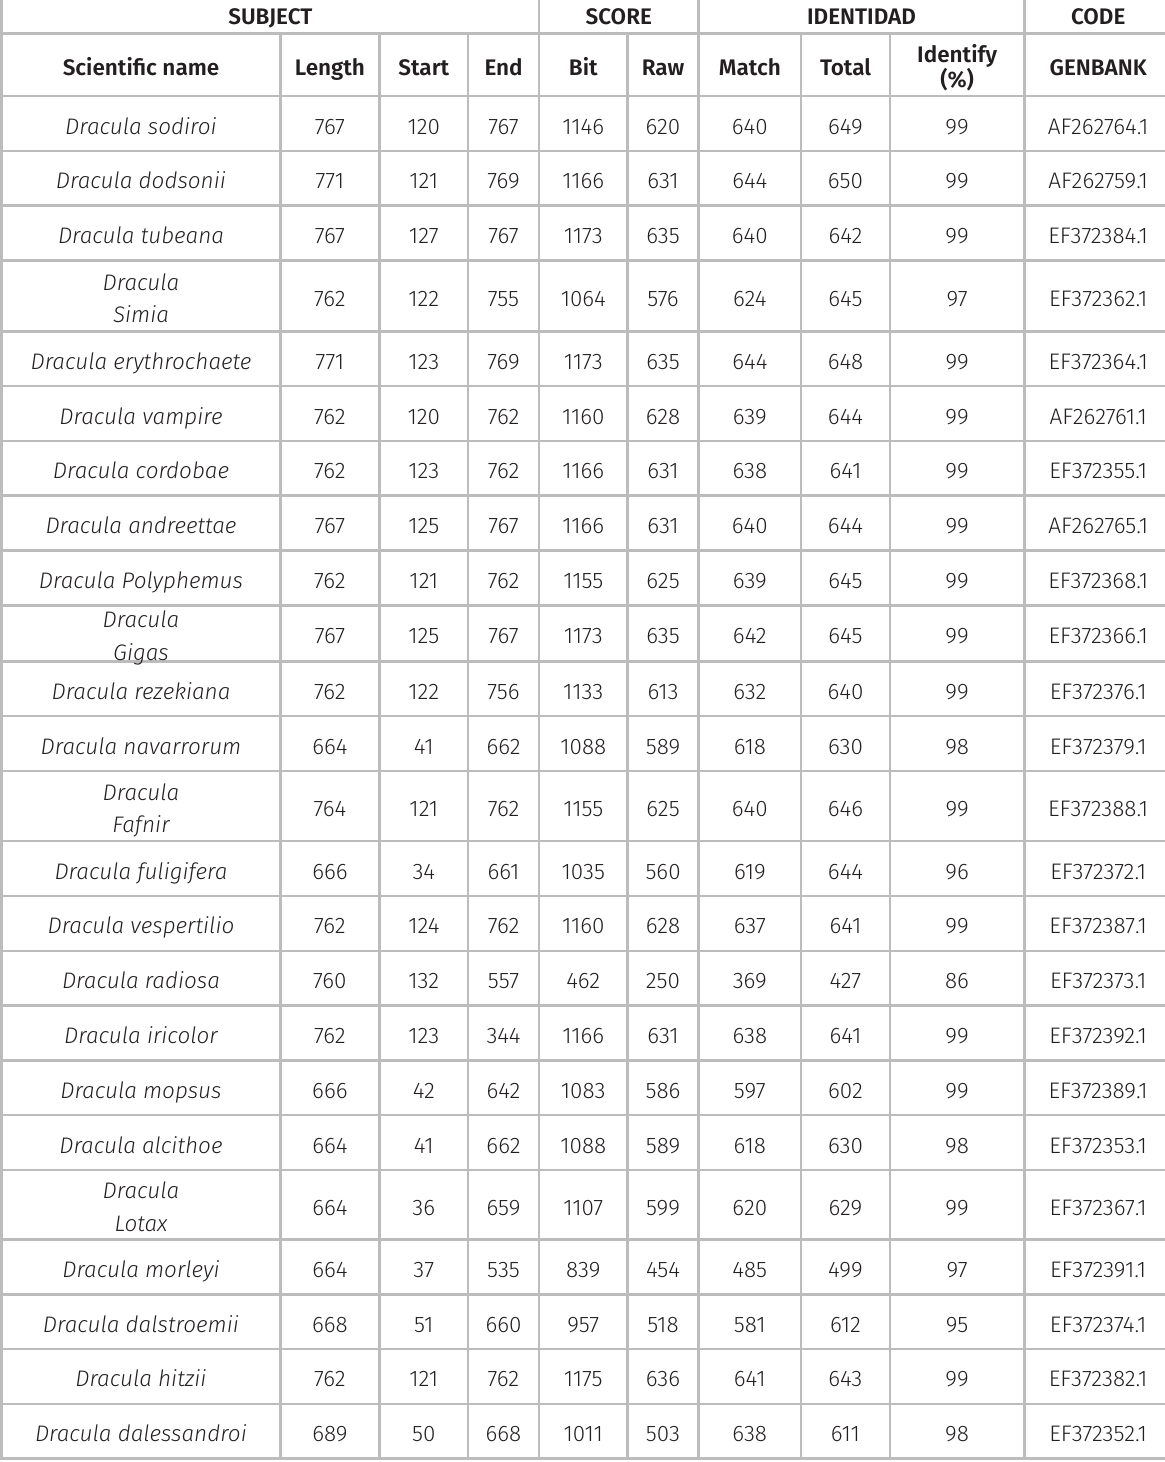
Table II. List of the species of orchids of the genus Dracula evaluated in this study that have sequences in the GenBank. It should be noted that except for Dracula radiosa , which has 86% similarity, all sequences have values greater than